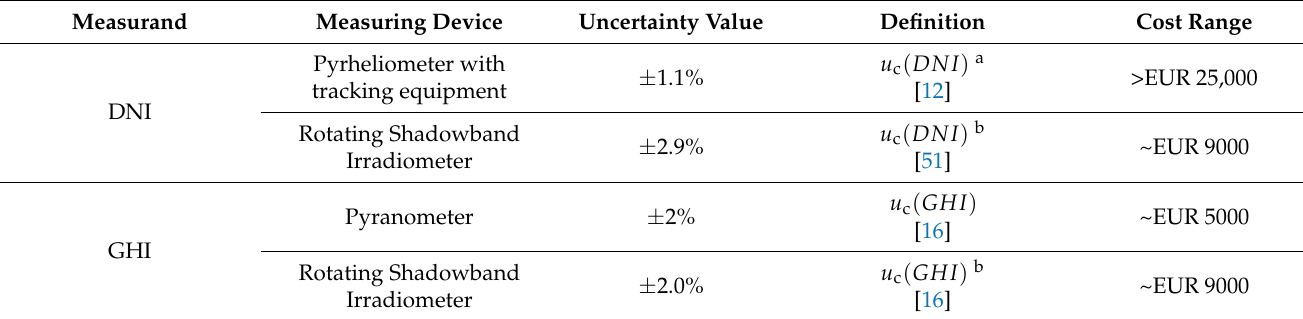
Table 3. Measurand, measuring device, measuring uncertainty and approximate cost range for irradiance data measurement equipment in parabolic trough collector